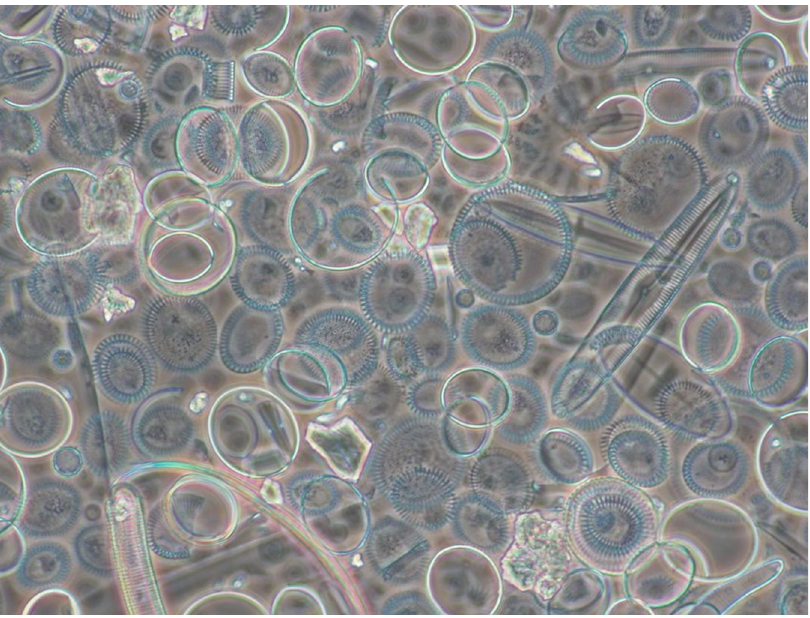
Fig 2. Example of a diatom sample (under light microscope) contaminated with aluminosilicates. Sample from Lake El’gygytgyn, Russia [15].